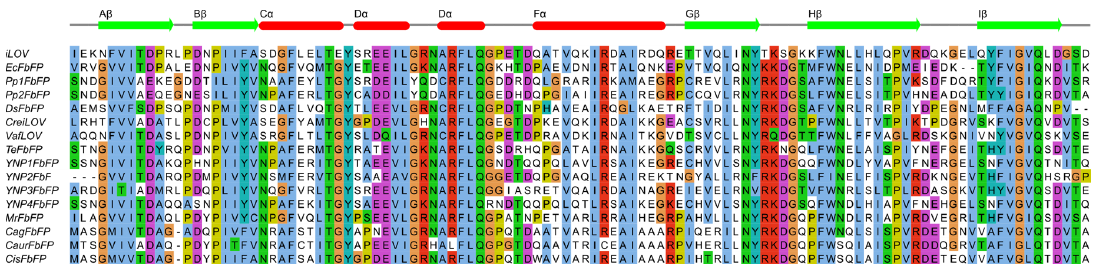
Figure 1. Multiple sequence alignment of LOV domain cores of different LOV-derived fluorescent